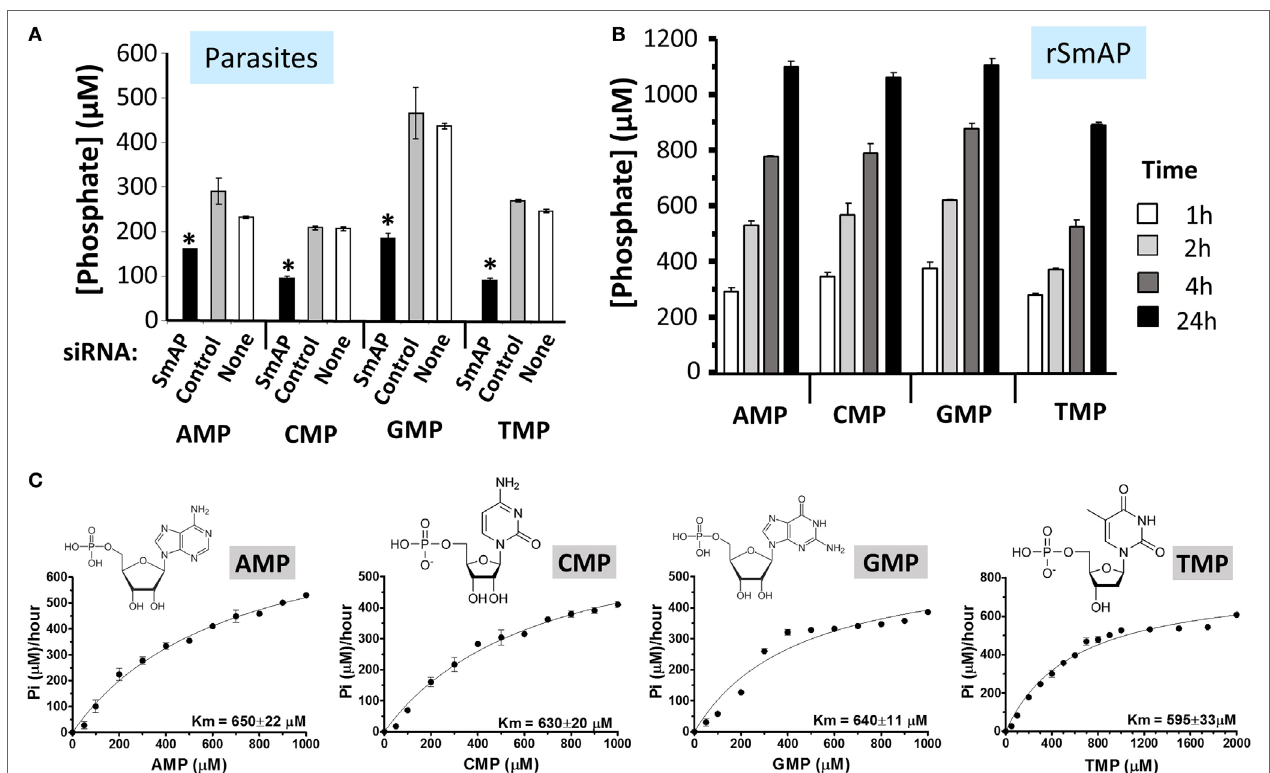
FigUre 4 | (a) Schistosoma mansoni alkaline phosphatase (SmAP) gene suppression by RNAi. Phosphate generation ( μ M, mean ± SD) by live schistosomula (groups of 1,000) 7 days after treatment with SmAP siRNA or an irrelevant siRNA (Control) or no siRNA (None) in the presence of different nucleoside monophosphates (NMPs) (AMP, CMP, GMP, or TMP, as indicated). In each case, parasites treated with SmAP siRNA generate significantly less phosphate compared to controls (*, one-way ANOVA, p < 0.05). (B) Phosphate generation ( μ M, mean ± SD) by rSmAP over time with AMP, CMP, GMP, or TMP (as indicated) as substrate. (c) Michaelis–Menton plots of SmAP-mediated AMP, CMP, GMP, or TMP (as indicated) cleavage kinetics, generated, and analyzed using GraphPad Prism 5.0; the chemical structures of each of the NMPs as well as the mean Km values of rSmAP for each is given. Km values were derived from three independent